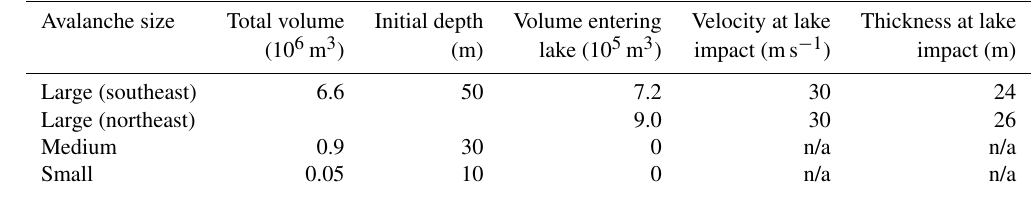
Table 5. Results for various avalanche scenarios in 2045, showing parameters needed for the Heller–Hager model.